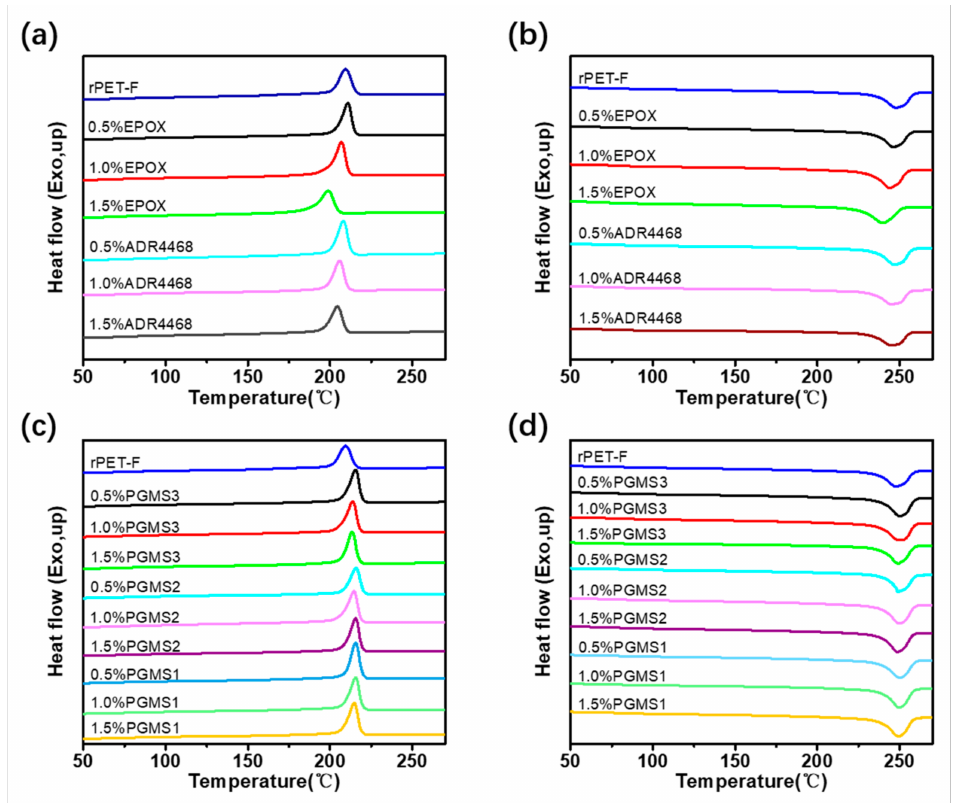
Figure 3. DSC curves for rPET-F modified by EPOX and ADR-4468, ( a ) cooling scan, ( b ) heating scan; DSC curves for rPET-F modified by different PGMS, ( c ) cooling scan, ( d ) heating scan. Table 4. The crystallization temperature, melting point and glass transition temperature of modified rPET-F